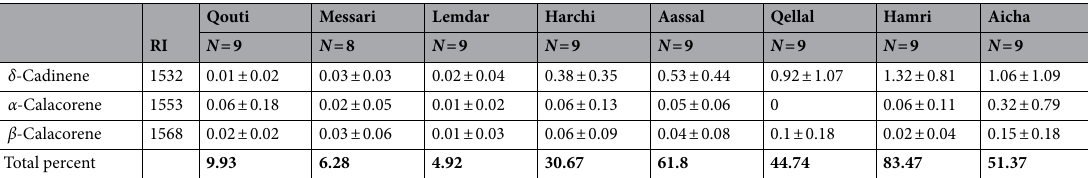
Table 1. Relative proportions of all volatile organic compounds (VOCs) emitted by receptive figs of the eight varieties of Ficus carica . Compounds detected are divided into four groups based on general biosynthetic origin. Within each group, compounds are listed in order of their retention index (RI). For each variety, the mean (± standard errors) of percentages of the VOCs per individual are presented. N, number of individual trees used for scent extraction. *Pollinator-attractive VOCs. Fur. Furanoid, Pyr. Pyranoid. a identified with synthetic reference. The total percentage of each chemical group for each variety is indicated in bold.